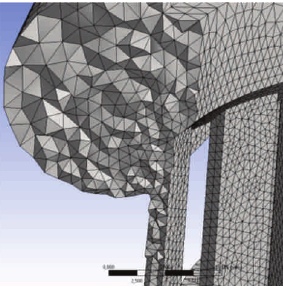
Fig. 6. Computational grid of fluid jacket model, with a minimum element size of 0.8 mm